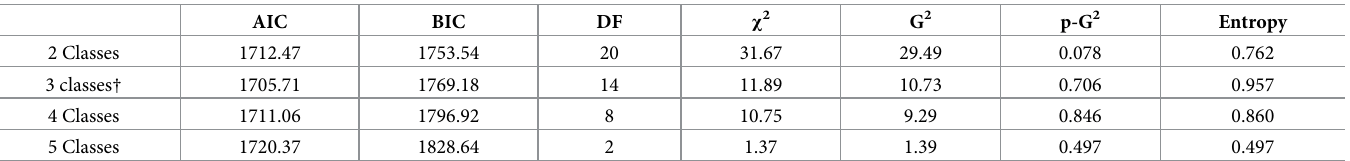
Table 1. Relative, absolute adjustment values, and adolescents LCA movement behavior models uncertainty